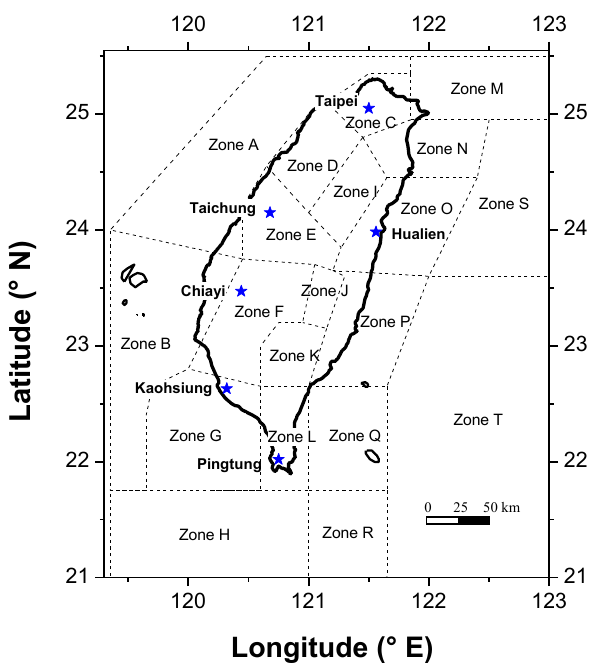
Figure 2. The area seismic source model for Taiwan (after Cheng et al., 2007); six study cities – (a) Taipei, (b) Kaohsiung, (c) Taichung, (d) Chiayi, (e) Pingtung, and (f) Hualien – are plotted as blue